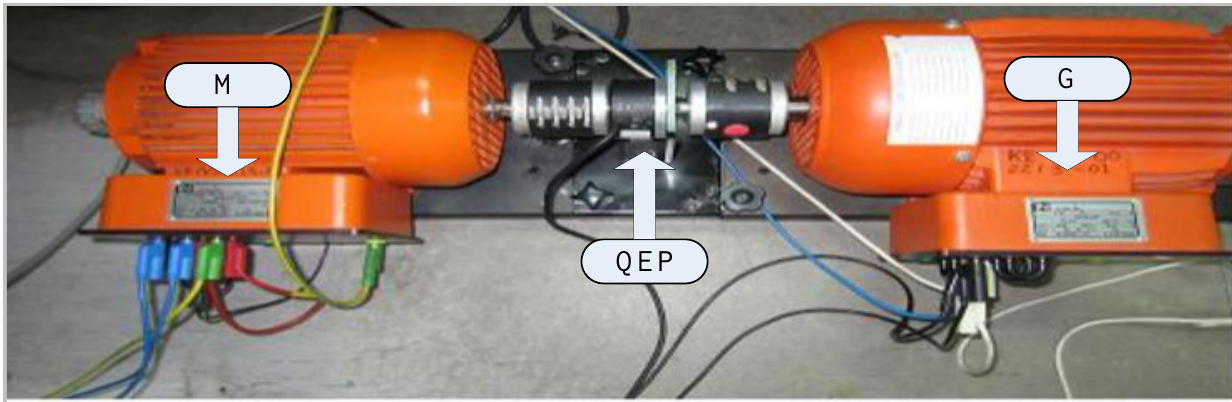
Figure 15. Connection of encoder for IM